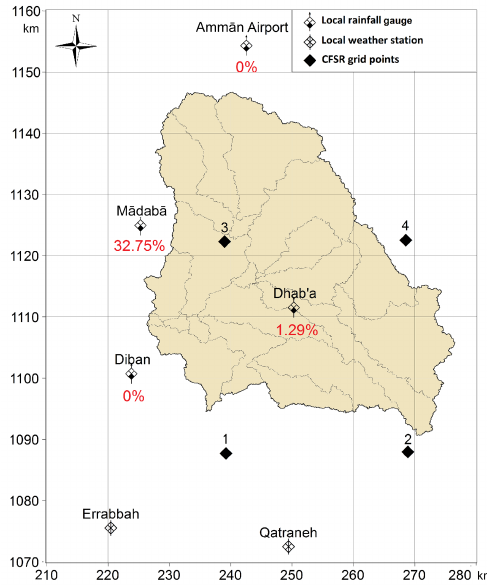
Figure 5. Local weather stations, CFSR grid points; and local rainfall gauges with their percentage of missing data over the pe- riod